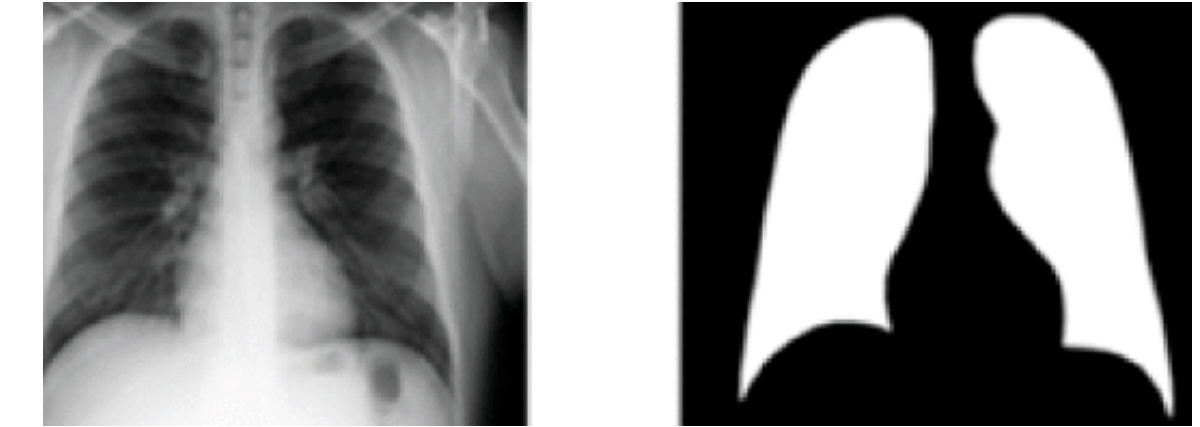
Figure 2. X-ray instance and their analogous mask from the Kaggle database. Four public datasets are utilized for pneumonia classification. The datasets are PND Pneumonia, BelPnem dataset, NIAPn Pneumonia dataset and RPNA dataset: the PND database is found in the US public library of medicine [25], and it has two pulmonary X-ray datasets containing 230 and 767 posterior-anterior lung X-rays. The X-ray image resolution is 2048 × 2048 pixels. In the first dataset (DS1) of 230 X-rays, 100 images are captured from diverse pneumonia cases and 130 images are from healthy cases. In the second dataset (DS2), out of 767 X-rays, 467 X-rays are captured from pneumonia cases and 300 X-rays are normal cases. Thus, in this PND dataset, there are 430 normal and 567 Pneumonia